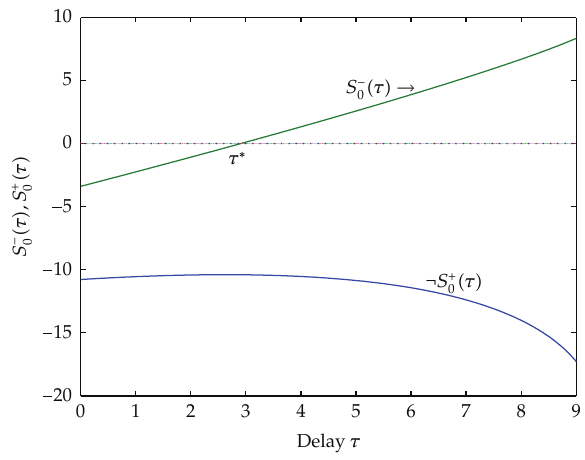
(cid:2) τ (cid:5) and S − 0